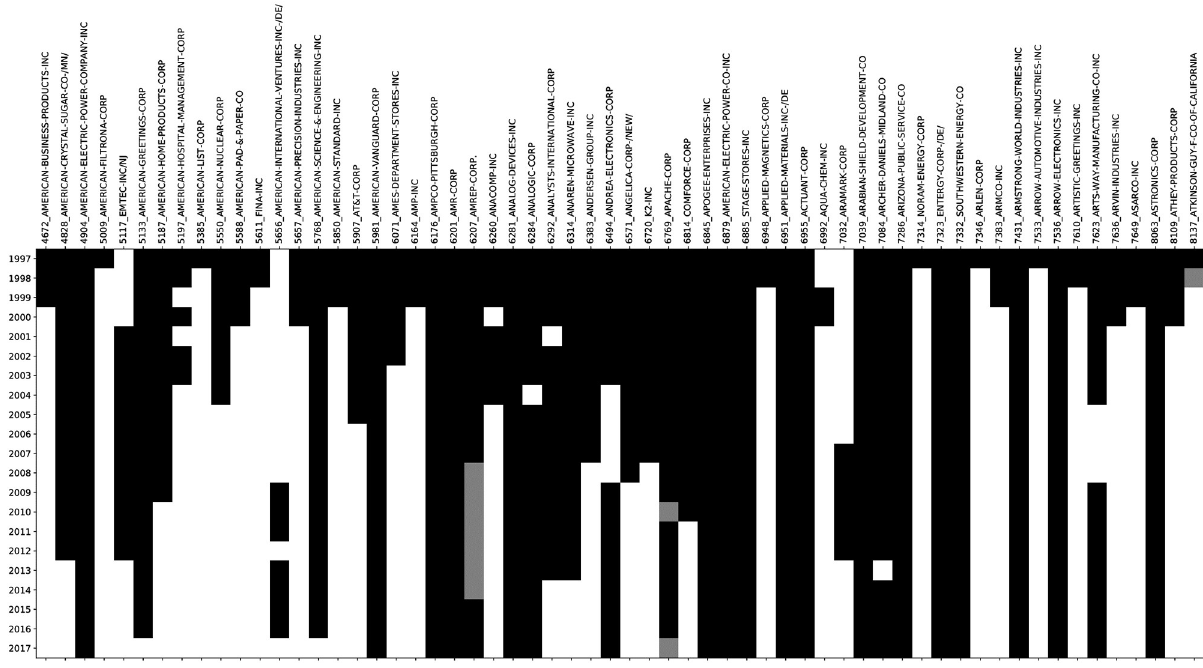
Fig 5. Map of annual documents for 30 firms in the model training corpus. Documents are sorted into firm (columns) and filing year (row). Black cells indicate documents in the corpus, grey cells indicate documents in the SRAF dataset that were removed because they lacked the information we needed. White cells indicate years when there is no document for that company in the SRAF